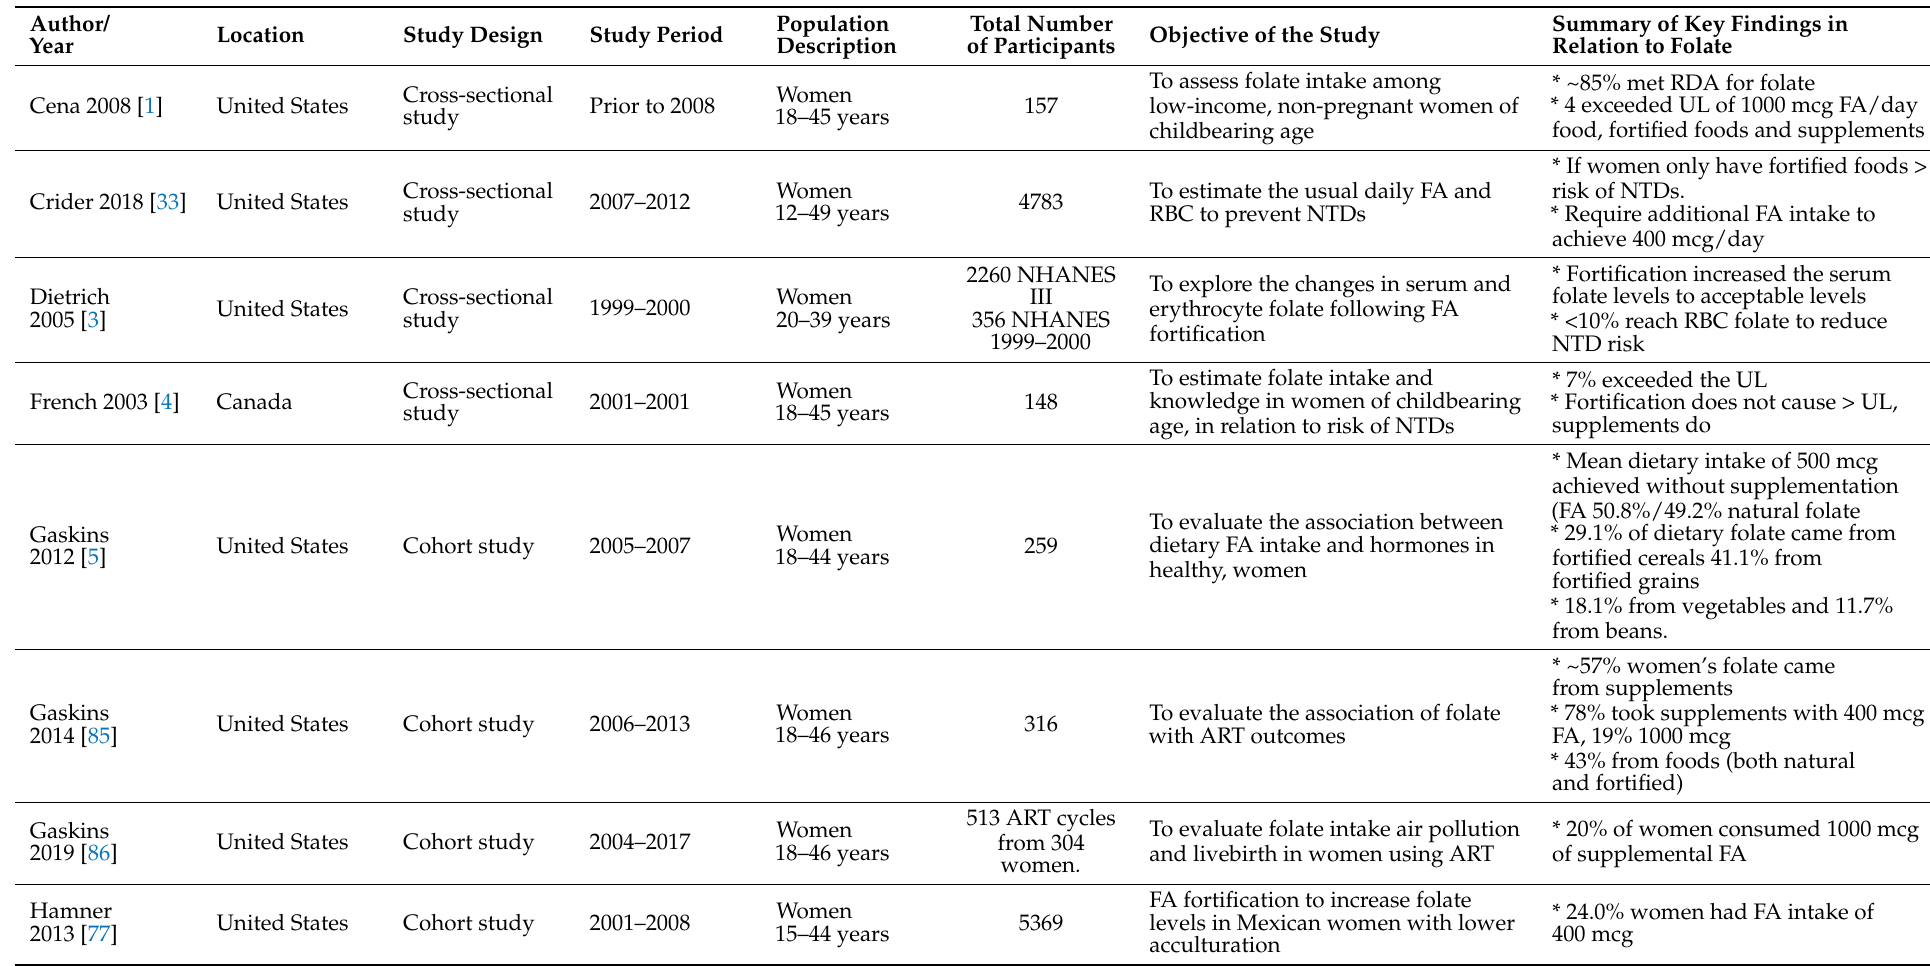
Table 1. Included studies sampling women of childbearing age, not